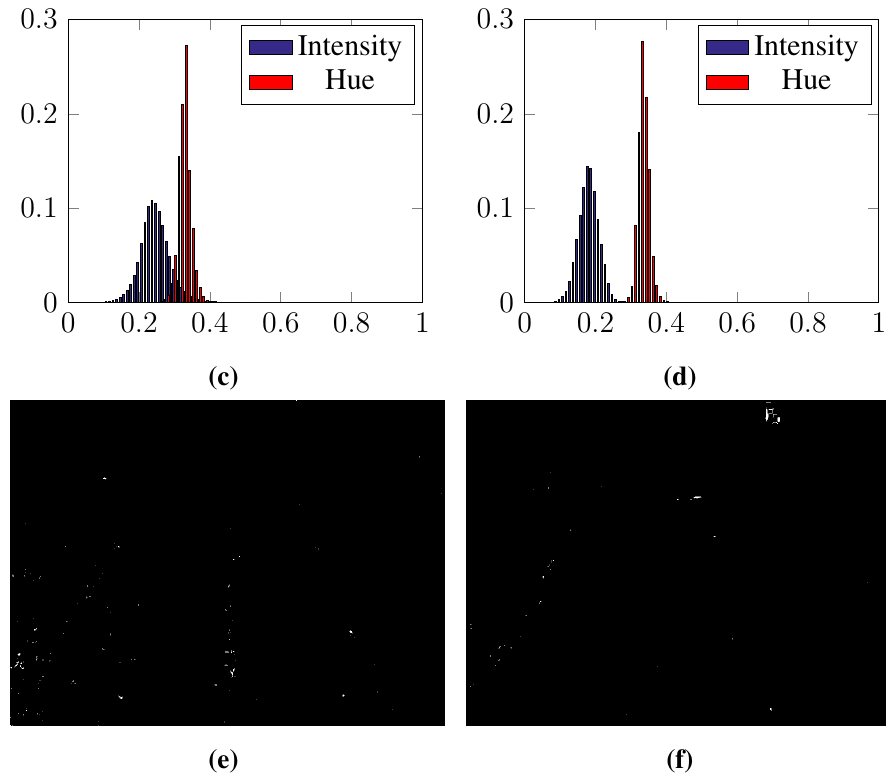
Figure 8. Incremental background model simulation. ( a ) Bright RGB color image (initial reference region); ( b ) dark RGB color image simulating a cloud; ( c ) background model for bright image; ( d ) updated model based on the incremental update of the histograms; ( e ) resulting foreground detection for the bright image; ( f ) foreground detection for the dark image (there is a nest just above the center of the